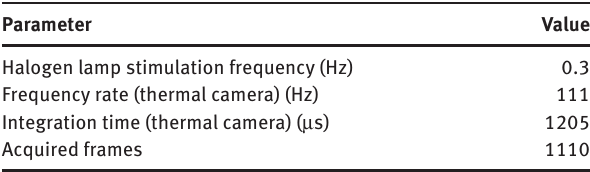
Table 1 Lock-in test